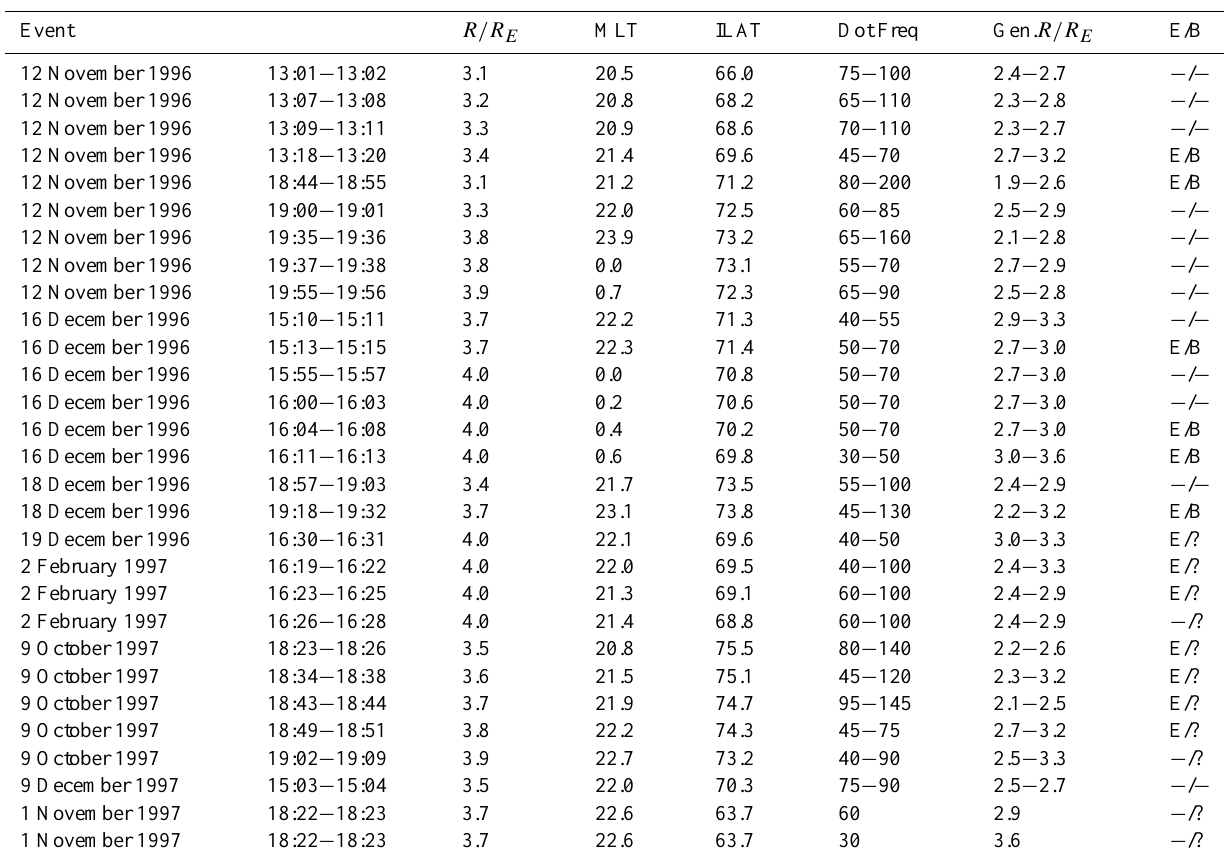
Table 1. Interball dot-AKR events. Event